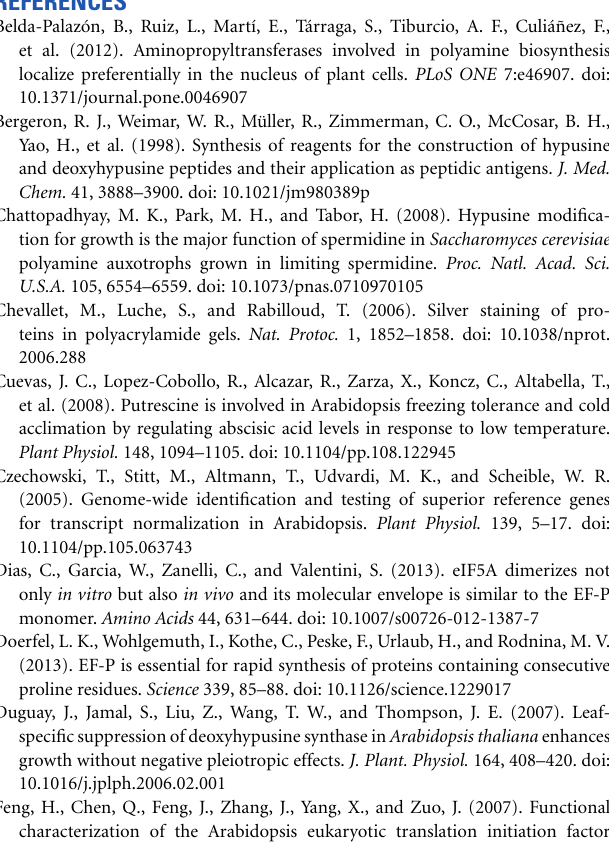
Figure S1 | Determination of the presence of hypusine by GCMS. GCxGC/TOF-MS extracted ion chromatogram (m/z 375 + 174) of GST-eIF5A3 hydrolyzed protein. (A) Hypusinated; (B) non-hypusinated control; (C) mass spectrum of hypusine-TMS. Figure S2 | CK2-dependent phosphorylation changes in eIF5A1 protein. The same amount of protein extract from 10 old day CKA3 mut plants grown additionally for 3 days in the absence (A) or in the presence (B) of 10 μ M dexamethasone, for CK2 conditional inactivation, were subjected to 2D-E and western blot analysis with anti-eIF5A1 antibody. Similar results were obtained in two independent technical